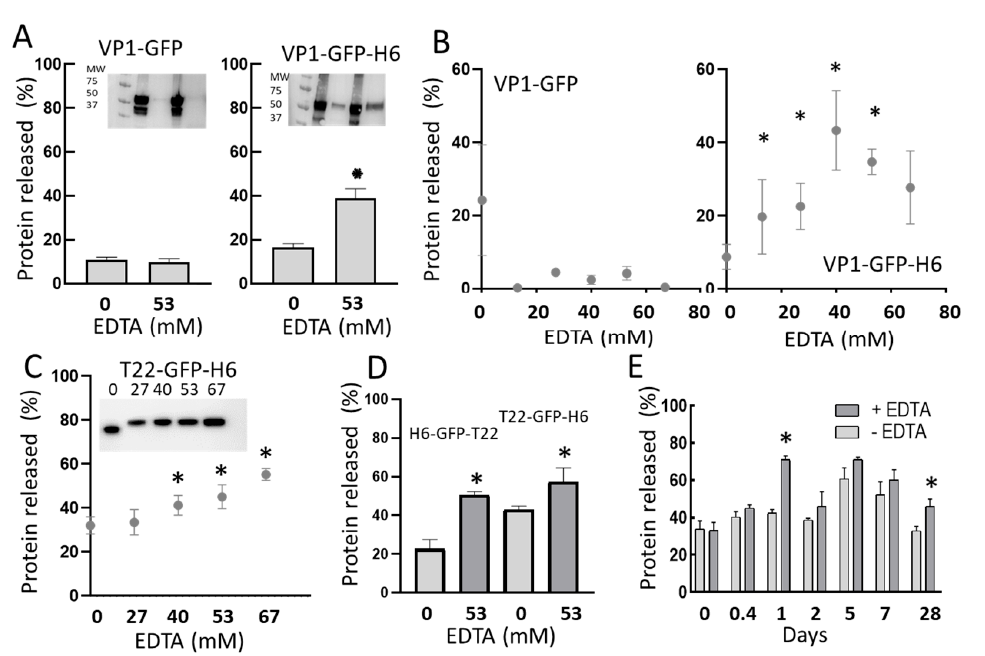
Figure 3. Protein release from IBs. ( A ) Fraction of protein released from untagged or H6-tagged IBs, determined by densitometric analyses of Western Blotting (inset), after 48 h of incubation at 37 °C in buffer or in buffer in presence of 53 mM EDTA. ( B ) Protein release from VP1 ‐ GFP and VP1 ‐ GFP ‐ H6 IBs under increasing concentrations of EDTA. ( C ) Protein release from T22 ‐ GFP ‐ H6 IBs under increasing concentrations of EDTA. Numbers above the Western blot (inset) indicate EDTA concentration in mM. ( D ) Protein release from H6 ‐ GFP ‐ T22 and T22 ‐ GFP ‐ H6 IBs, in the absence or in the presence of EDTA. ( E ) Time prolonged protein release, with or without EDTA (53 mM), from T22 ‐ GFP ‐ H6 IBs. * Statistically different to the condition without EDTA ( p < 0.1) in all panels.